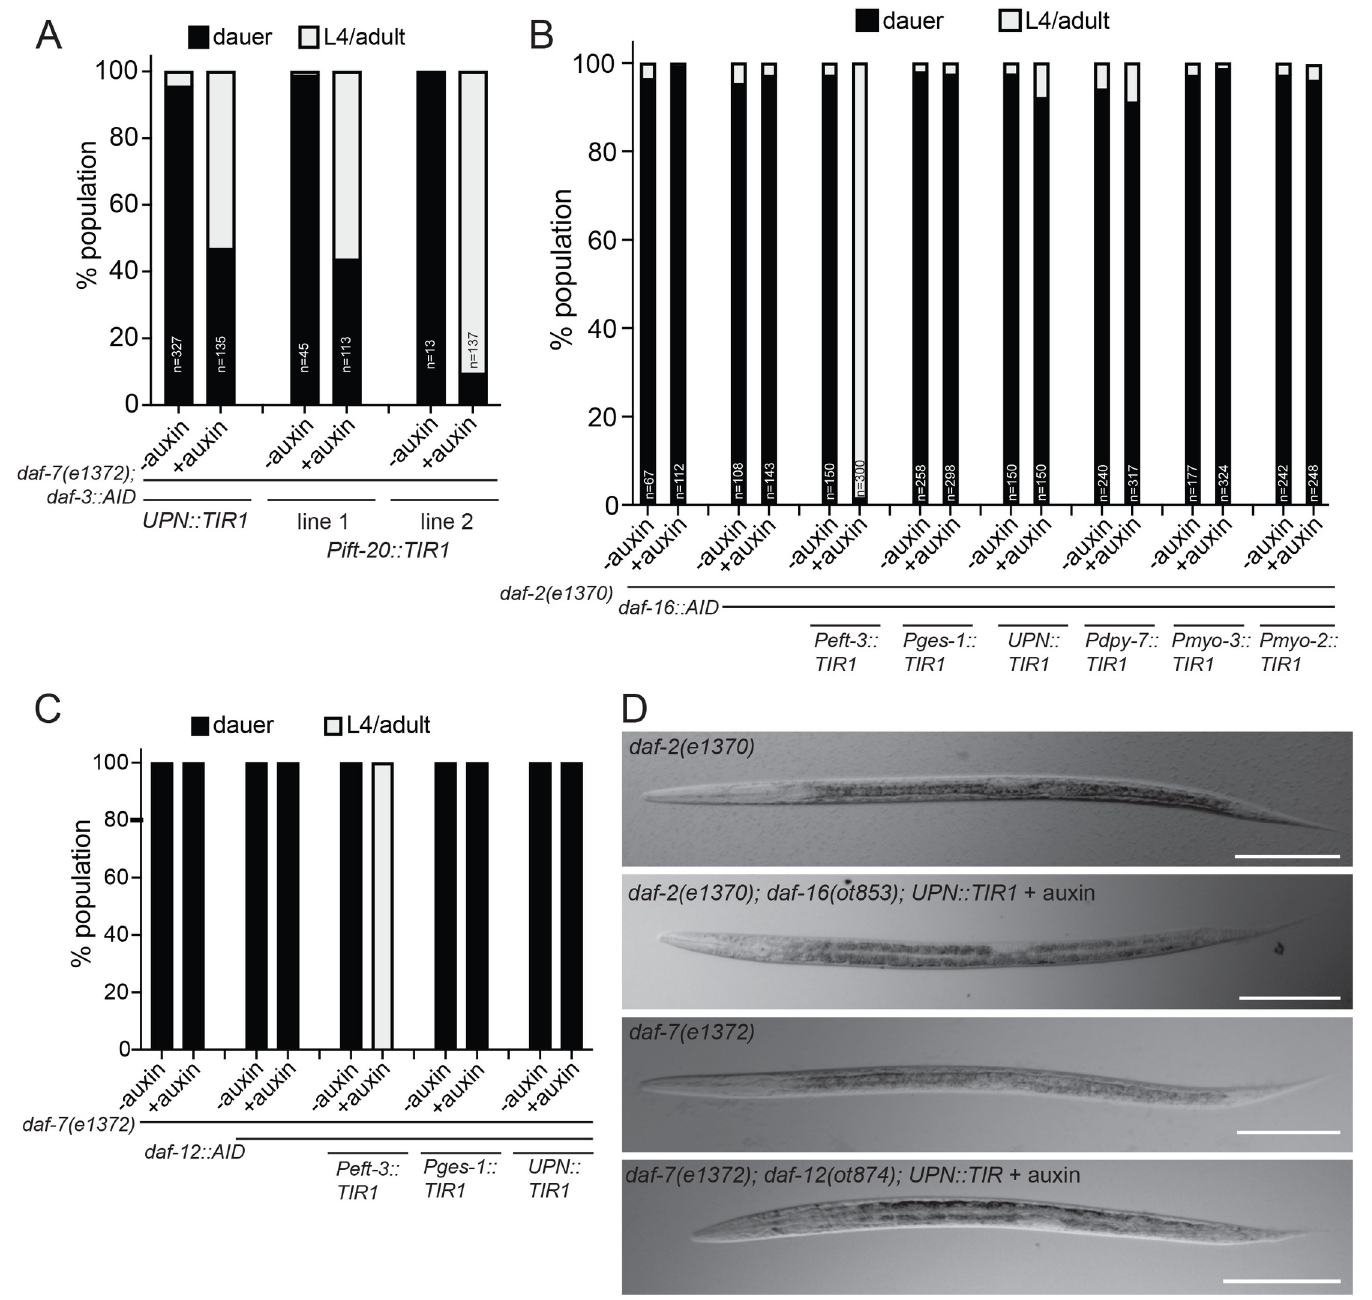
Fig 4. Neuronal depletion of DAF-3/SMAD, but not of DAF-16/FoxO or DAF-12/VDR, suppresses dauer formation. ( A ) Quantification of dauer formation upon depletion of DAF-3/SMAD with a panneuronal ( otIs730[UPN :: TIR1 :: mTurquoise2] )and a pansensory TIR1 ( otEx[Pift-20 :: TIR1 :: mRuby] )drivers. We note that Greer et al. observed that expression of the TGF β receptor DAF-1 in the RIM/RIC interneurons is sufficient to rescue the dauer phenotype of daf-1 mutants [46], but these sufficiency experiments are conceptually distinct from our necessity experiments. ( B ) Quantification of dauer formation upon tissue-specific depletion of DAF-16/FoxO. ( C ) Quantification of dauer formation upon tissue-specific depletion of DAF-12/VDR. ( D ) Overall appearance of dauers with panneuronal depletion of DAF-16/FoxO and DAF-12/VDR is superficially similar to that of the background Daf-c strains, daf-2(e1370) , and daf-7(e1372) , respectively. Scale bars, 60 μ m. The data underlying this figure can be found in S1